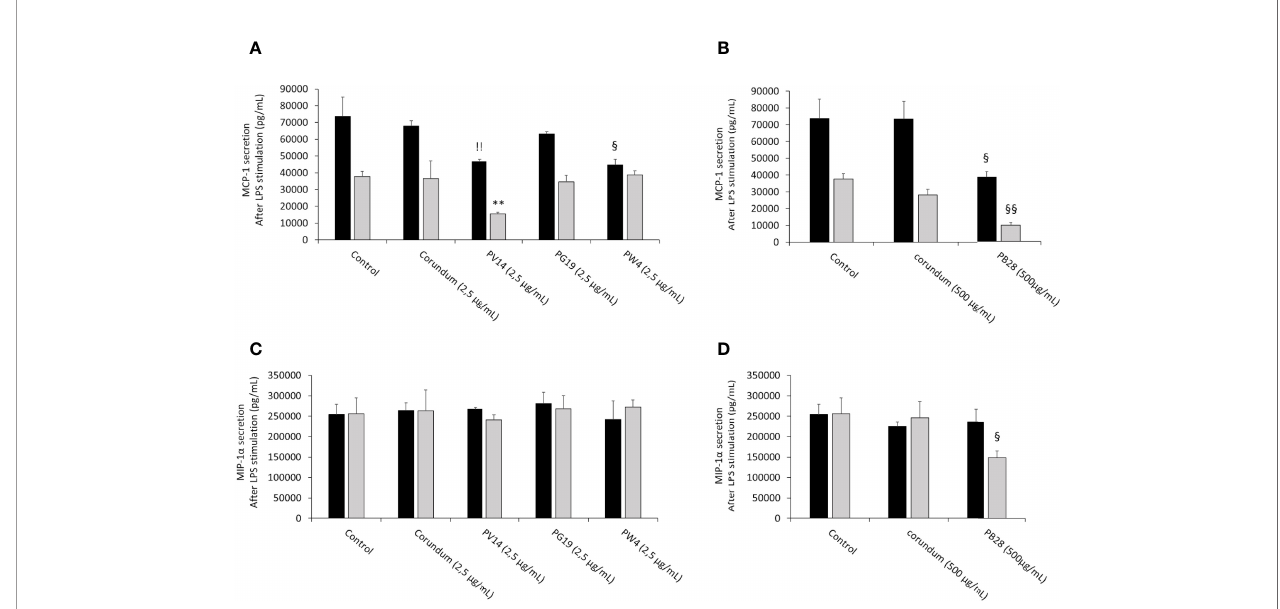
FIGURE 13 | chemoattractant cytokines secretion after LPS stimulation. Black bars: acute exposure (24 hours). Grey bars: exposure for 24 hours followed by a 3- day post-exposure recovery period. Panel (A) MCP-1 secretion. Conditions with 2.5 µg/ml of particle suspension. Panel (B) MCP-1 secretion. Conditions with 500 µg/ml of particle suspension. Panel (C) MIP-1 a secretion. Conditions with 2.5 µg/ml of particle suspension. Panel (D) MIP-1 a secretion. Condition with 500 µg/ml of particle suspension. Signi fi cance of symbols: *: different from negative control only; §: different from both negative and corundum controls;!: different from corundum control only. Number of symbols: 1: p < 0.05; 2: p <